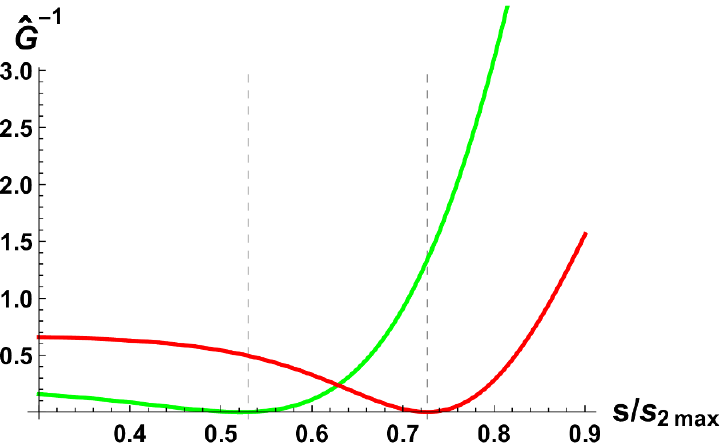
Figure 5 . Shear elastic modulus of the holographic viscoelastic media becomes very large (diverges in O ( (cid:14) 2 ) approximation) at the critical point. The color coding corresponds to di(cid:11)erent values of 2 the ratio of temperature T to the chemical potential (cid:22) : T the critical values of T=(cid:22) j crit at s = 0. The dashed lines indicate the critical points, in perfect agreement with (cid:12)gure